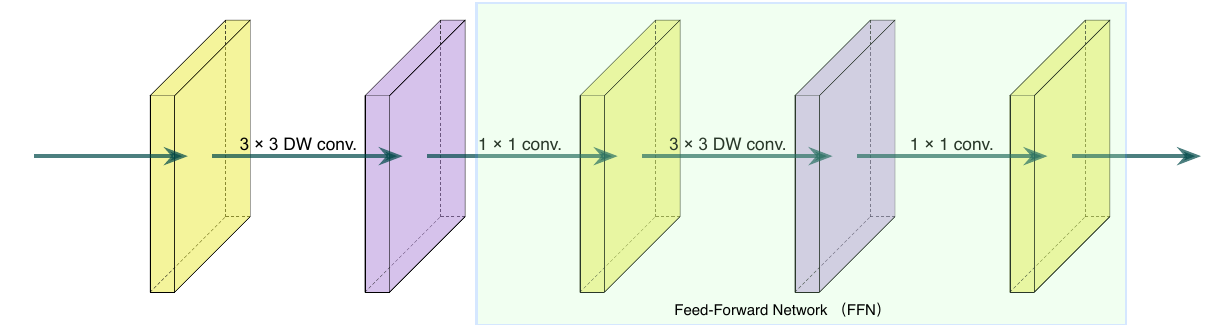
Figure 3. Illustrating the structure of our basic block.